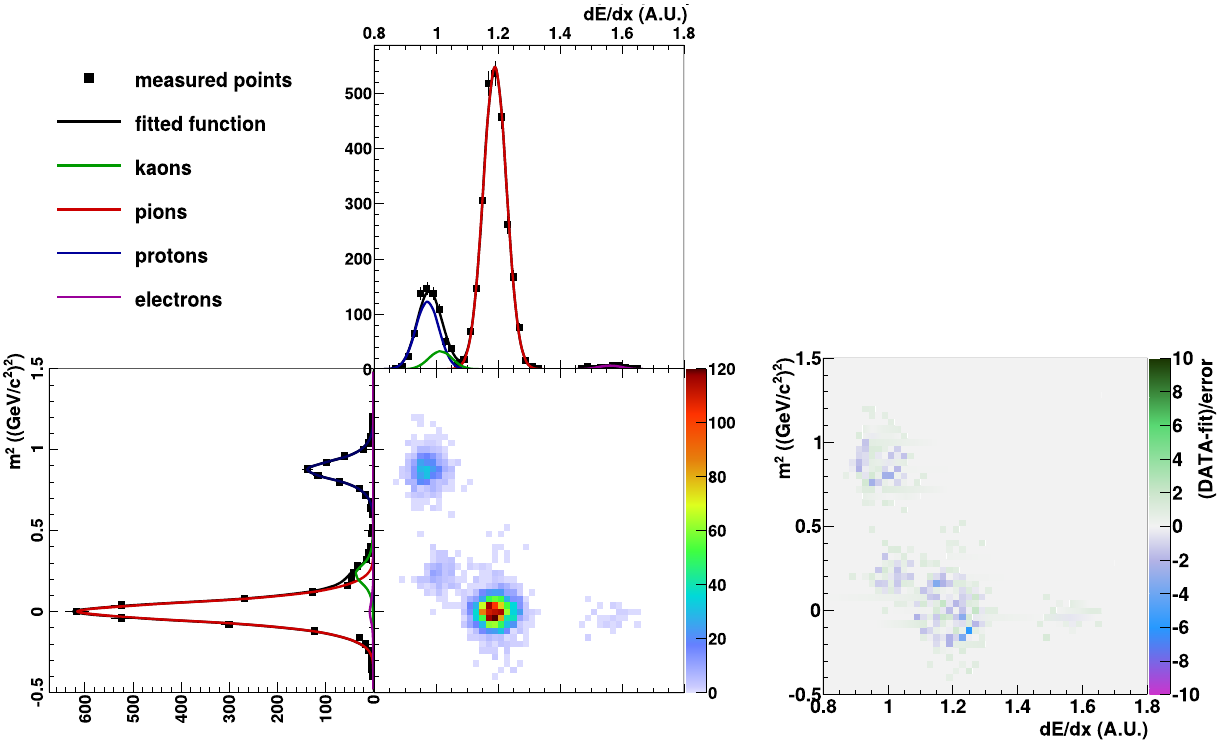
Fig. 12 Example of the tof -d E / d x fit (Eq. 4) obtained in a single phase-space bin (3 < p lab < 4 GeV / c and 0.3 < p T < 0.4 GeV / c ) for positively charged particles in PSD selected Be+Be collisions at